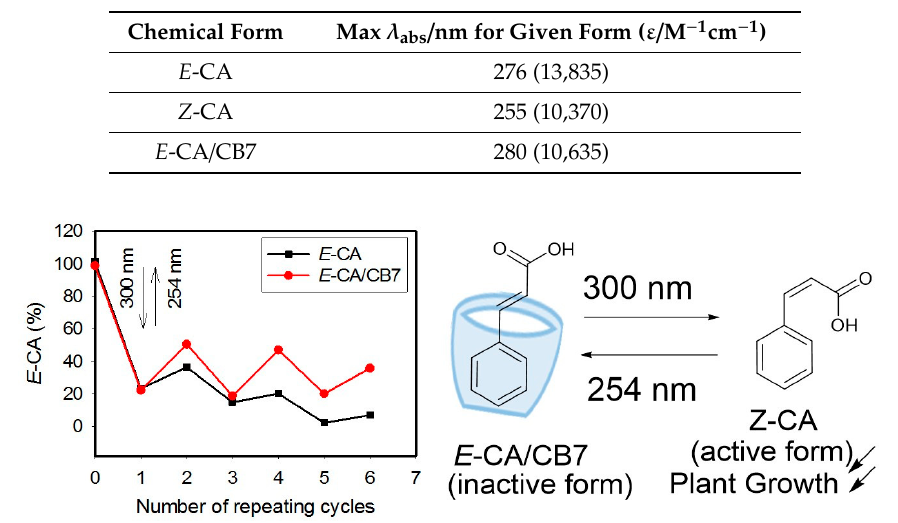
Figure 5. Percentage changes for E -CA upon repeated 300 nm (descending lines) and 254 nm (ascending lines) irradiation in water at pH 6 and 298 K in the absence (bottom, black lines) and presence of CB7 (top, red lines).